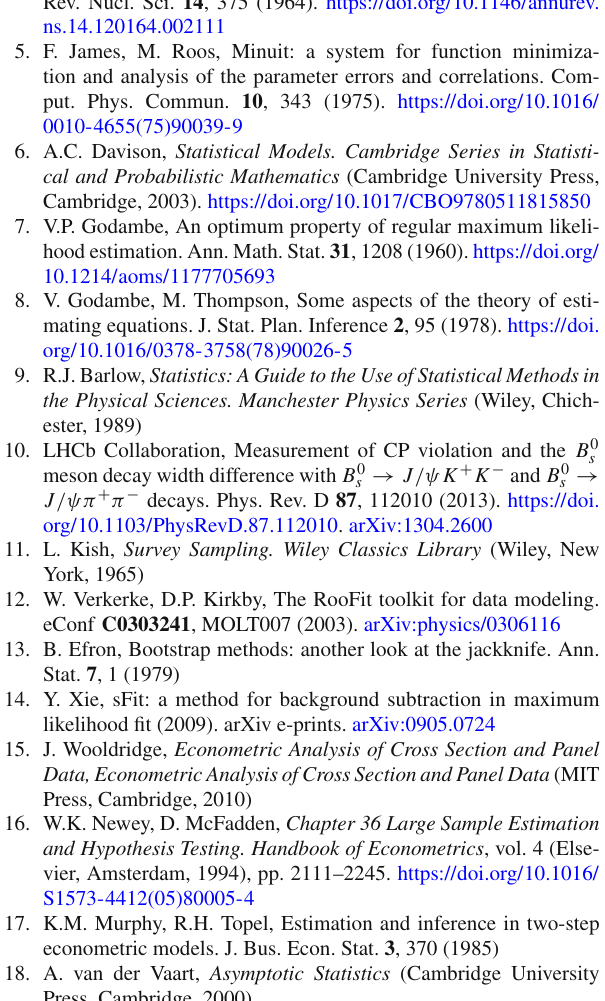
The means and widths of the resulting pull distributions are given in Tables 6 and 7. As for the case discussed in Sect. 4.2, the sFit , the scaled weights method and the squared weights method show significant undercoverage. All other methods, namely the ( full ) bootstrapping , the ( full ) asymp- totic method and the cFit show correct